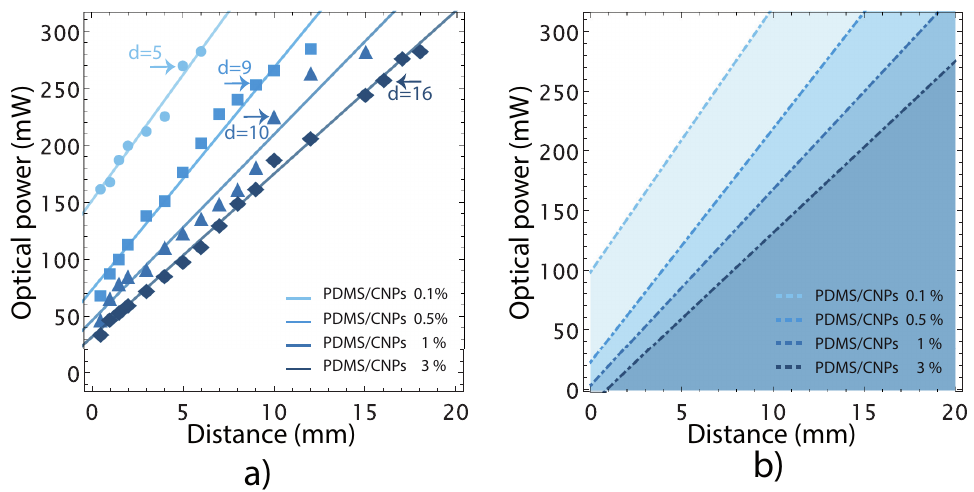
Figure 4. Optical power limits before thermal damage appears by incandescence in the nanocompos- ites: ( a ) optical power limits associated with their critical working distance for each nanocomposite; and ( b ) representation of safety regions considering a 20% less than the optical power limit for each nanocomposite. These shadowed regions represent safe (optical power and distance) working parameters to avoid